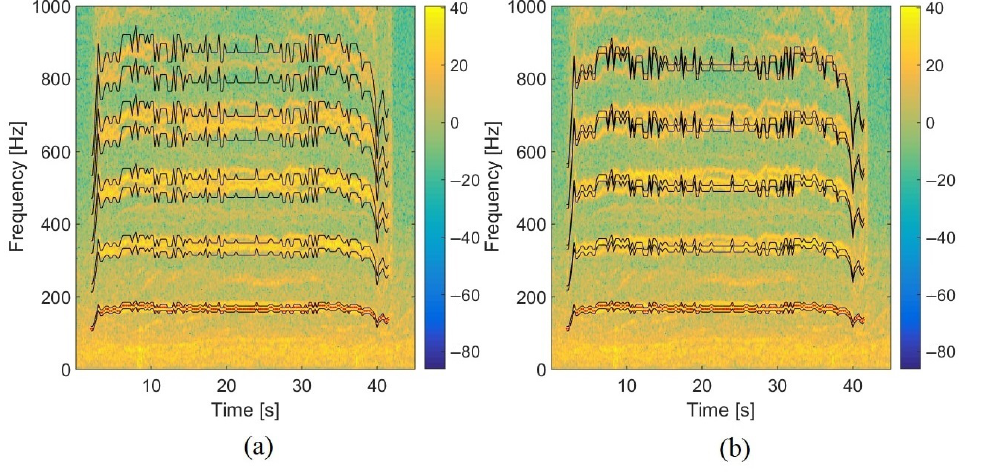
Figure 17. Spectrogram of the experimental trajectory highlighting the selected content in the TFR for Q = 10 ( a ) with the bandwidth varying with the center frequency, ( b ) with the constant bandwidth around harmonics (the red points are the estimated blade passing frequencies detected by